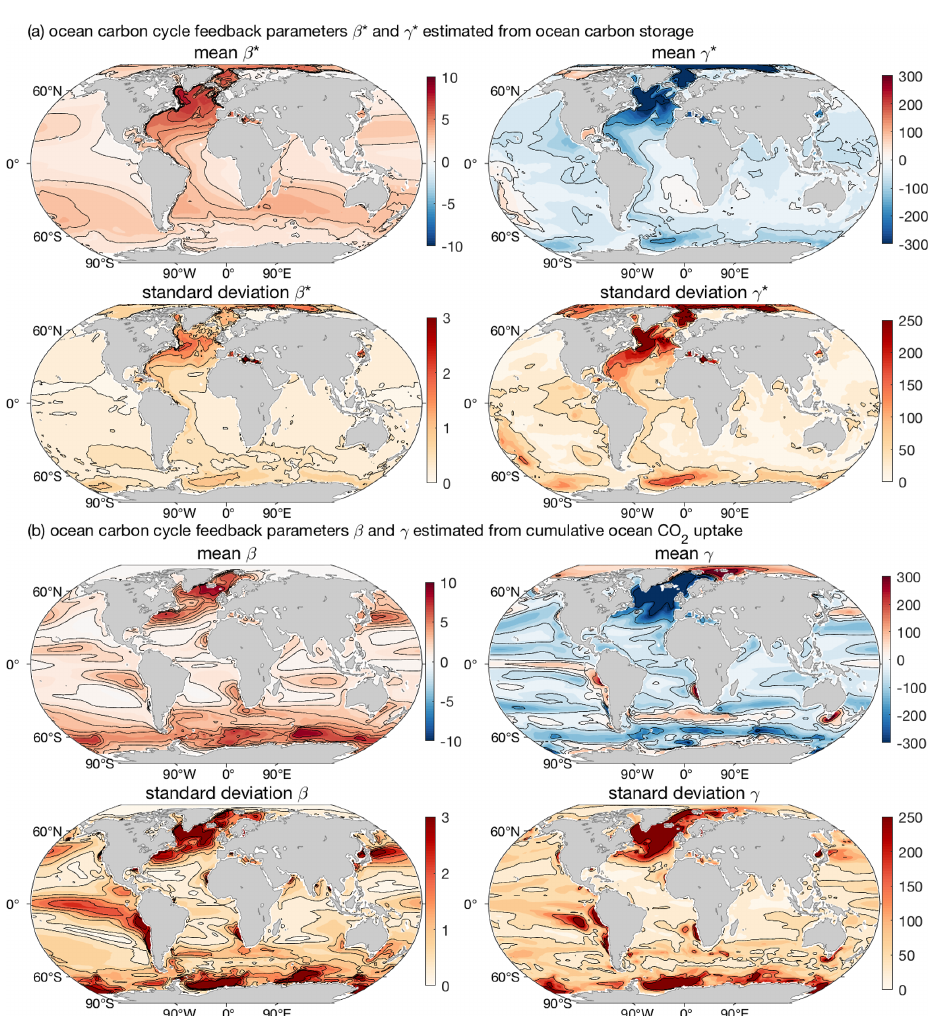
Figure 2. Geographical distribution of the carbon cycle feedback parameters normalised by area: (a) β ∗ (gCppm − 1 m − 2 ) and γ ∗ (gCK − 1 m − 2 ), estimated based on the regional ocean carbon storage, and (b) β (gCppm − 1 m − 2 ) and γ (gCK − 1 m − 2 ), estimated based on the regional cumulative ocean carbon uptake. Results are shown as the inter-model mean and standard deviation based on 11 CMIP6 Earth system models (Table 1). The estimates are based on the fully coupled simulation (COU) and the biogeochemically coupled simulation (BGC) under the 1%yr − 1 increasing CO 2 experiment. Diagnostics are from years 121 to 140 (the 20 years up to quadrupling of atmospheric CO 2